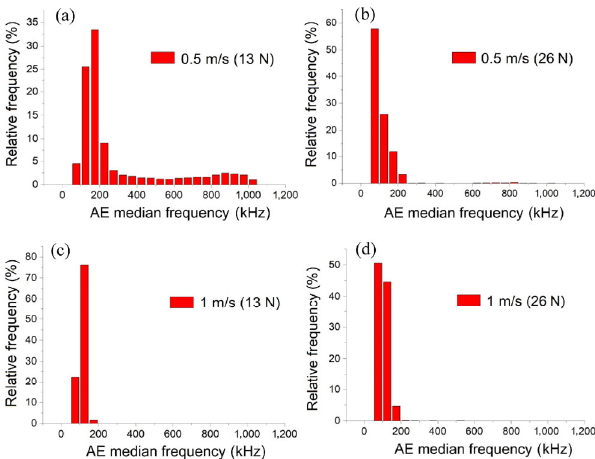
Fig. 3 Median frequency distribution histograms for Y-TZP in sliding at 0.5 m/s 13 N (a) and 26 N (b) and at 1 m/s 13 N (c) and 26 N